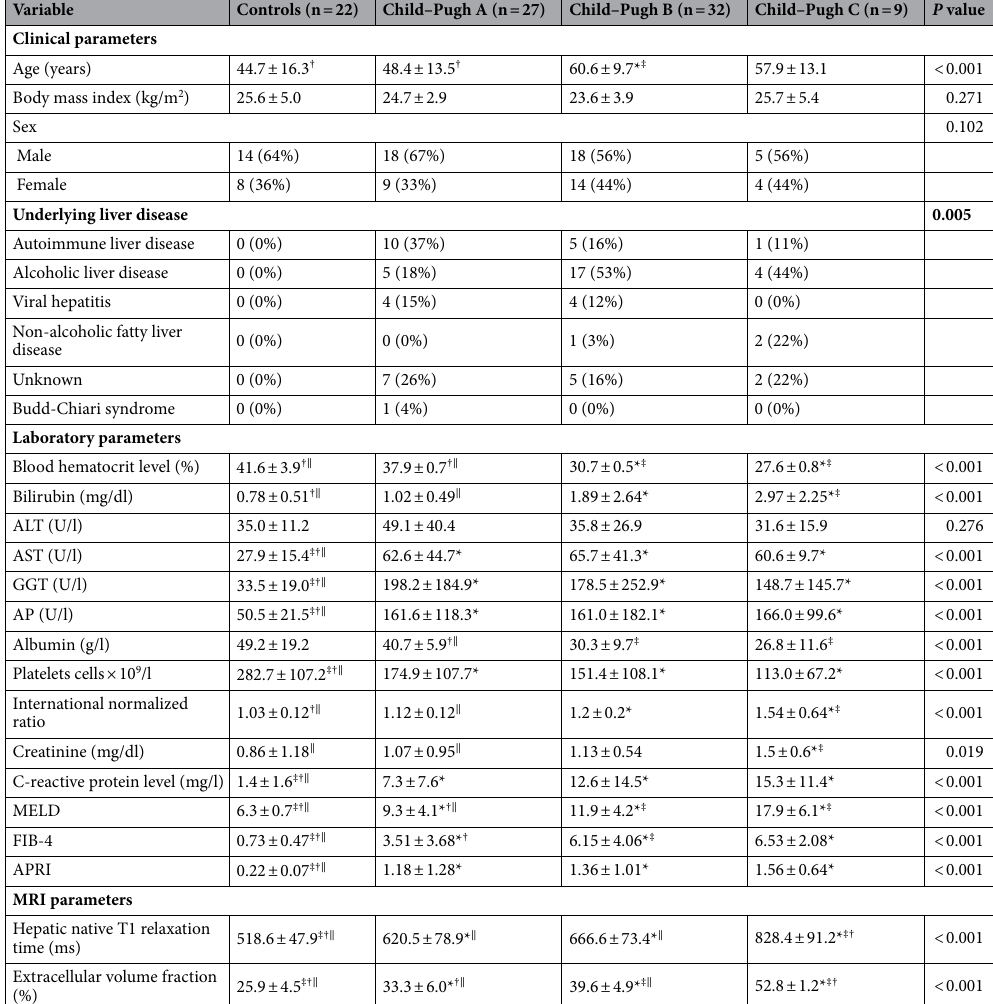
Table 1. Clinical, laboratory and quantitative magnetic resonance imaging (MRI) parameters of control subjects and patients with liver cirrhosis of different Child–Pugh classes. Continuous variables are given as means ± standard deviations. Nominal data are absolute frequencies with percentages in parentheses. P values were obtained using ANOVA test followed by Turkey’s multiple comparison test. MELD score model of end- stage liver disease, ALT alanine aminotransferase, AST aspartate aminotransferase, AP alkaline phosphatase, GGT gamma-glutamyltransferase, APRI aspartate aminotransferase to platelet ratio index, FIB-4 fibrosis-4- score. * P < 0.05 versus controls. ‡ P < 0.05 versus Child–Pugh A. † P < 0.05 versus Child–Pugh B. ‖ P < 0.05